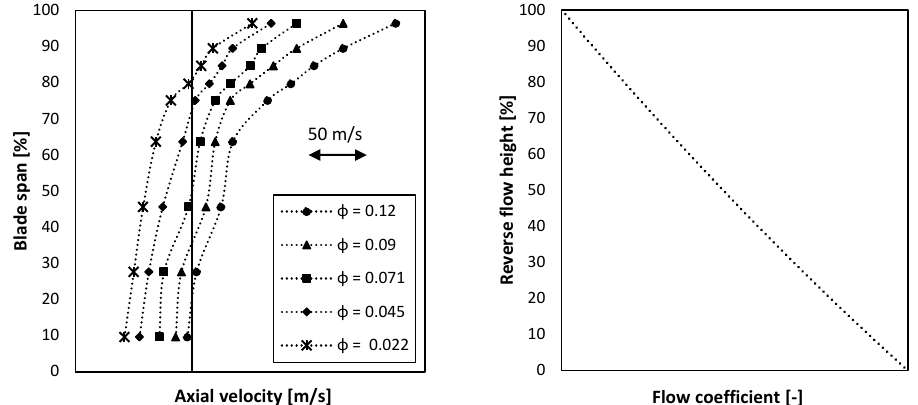
Figure 4. Distribution of the axial velocity along the blade span. ( left ) Mean values on CS62 plane; ( right ) mean reverse flow height. Axial velocity and flow coefficient values are not shown for confidentiality